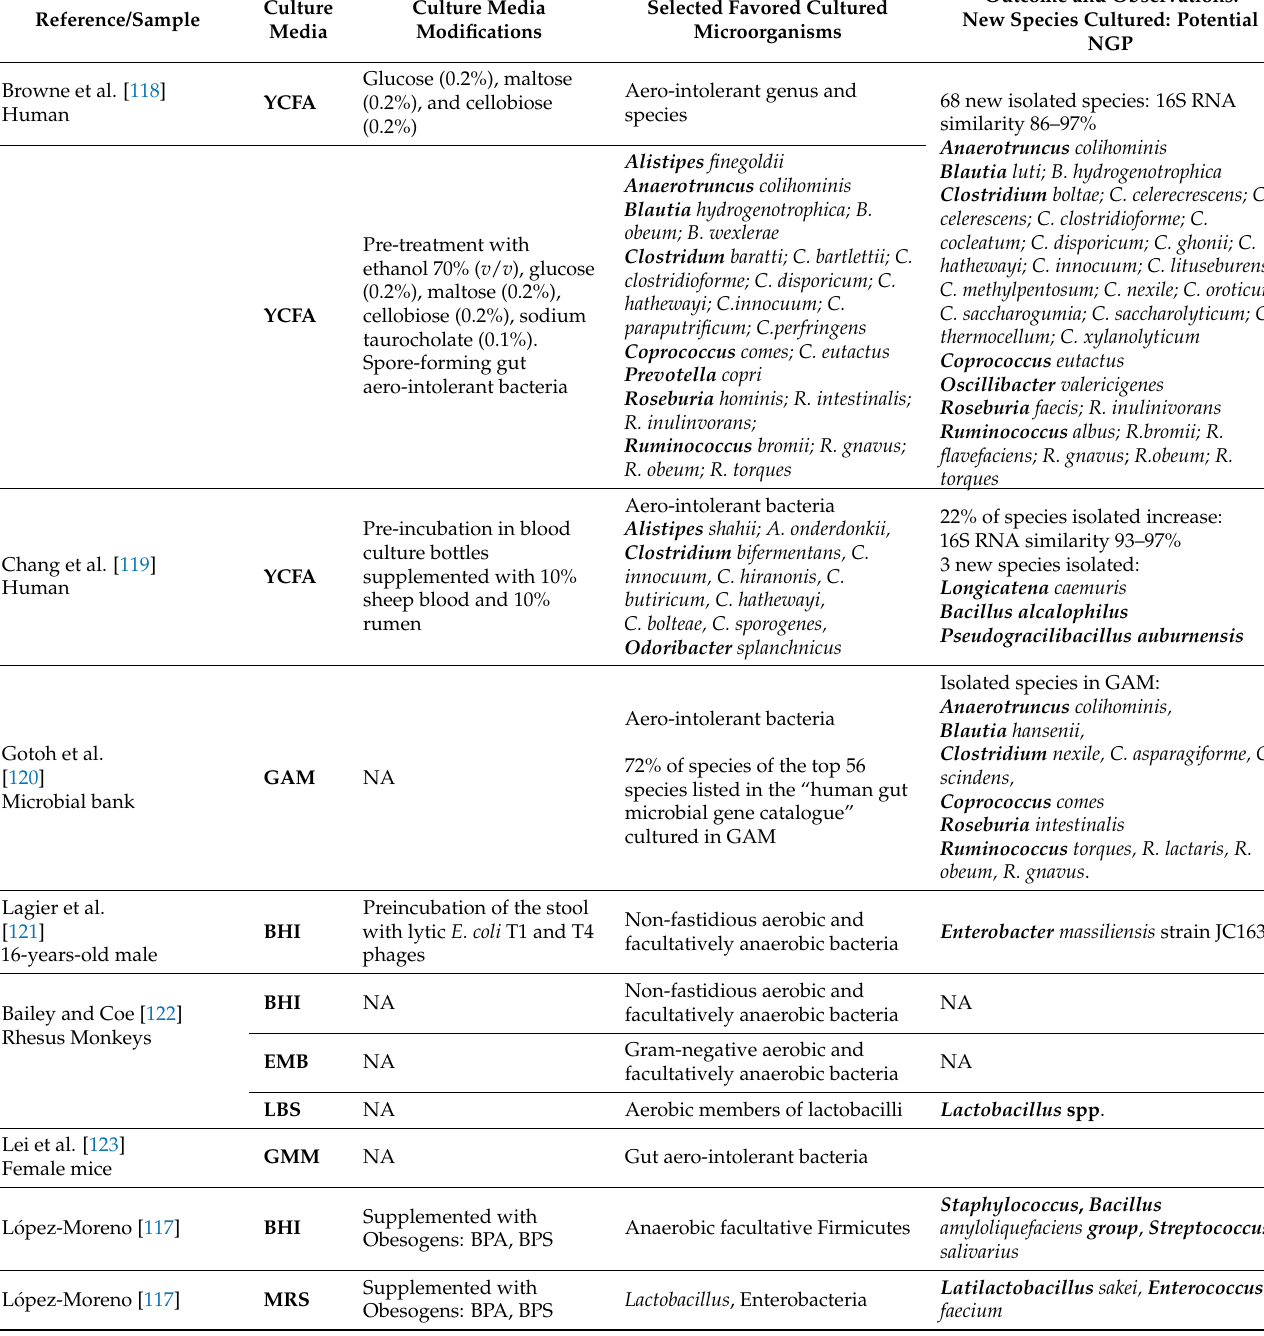
Table 4. Culturing approaches to favor specific microbiota species and NGP taxa and candidatus species.